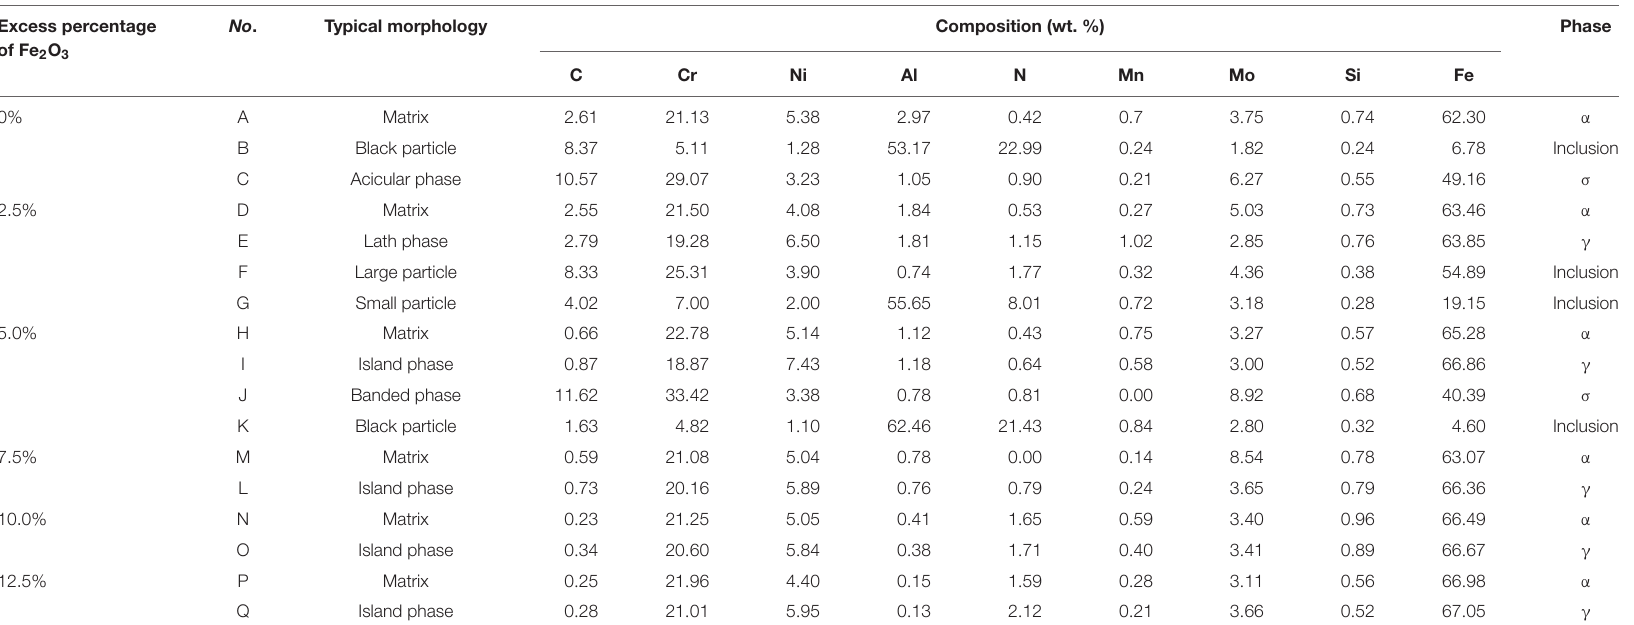
TABLE 2 | Elemental weight percentage of typical regions in the alloys. Excess percentage No . Typical morphology Composition (wt. %) Phase of Fe 2 O 3 C Cr 0%